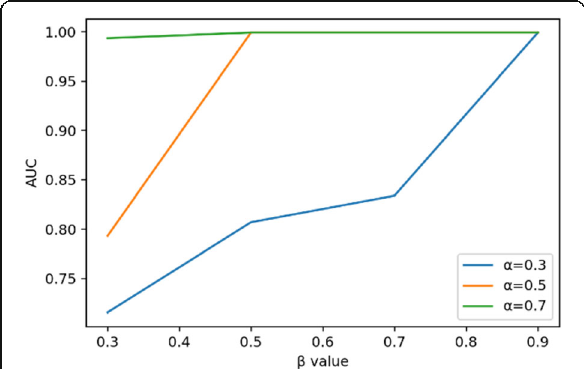
Fig. 11 The different parameters are employed in the function